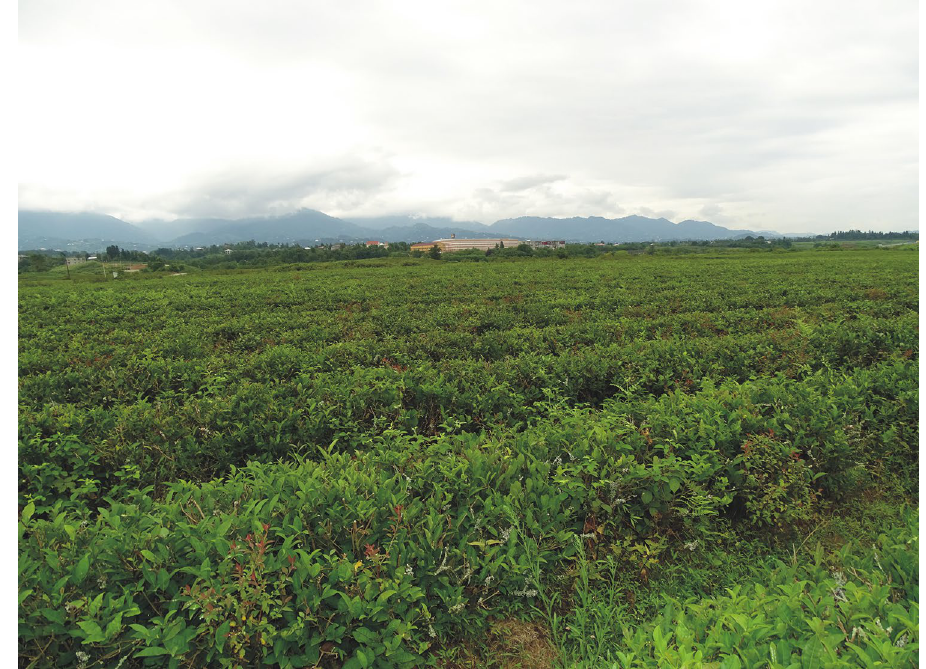
Figure 2. Tea plantation near Kobuleti (photo by R. Piwowarczyk, 29 July 2018).